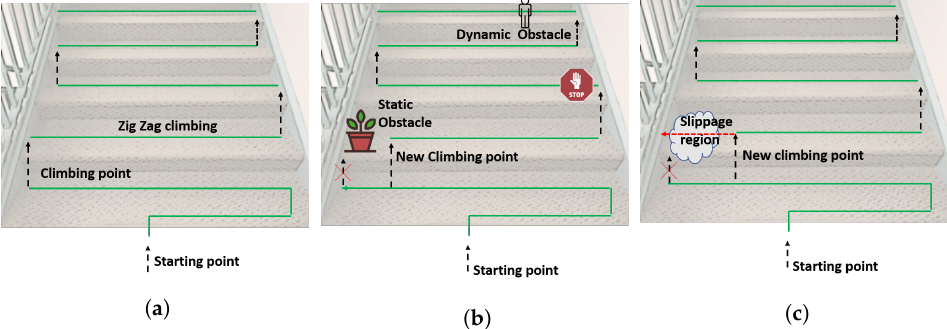
Figure 8. Trajectory planning, ( a ) zig-zag trajectory, ( b ) avoids obstacles while climbing, ( c ) avoid the slippage